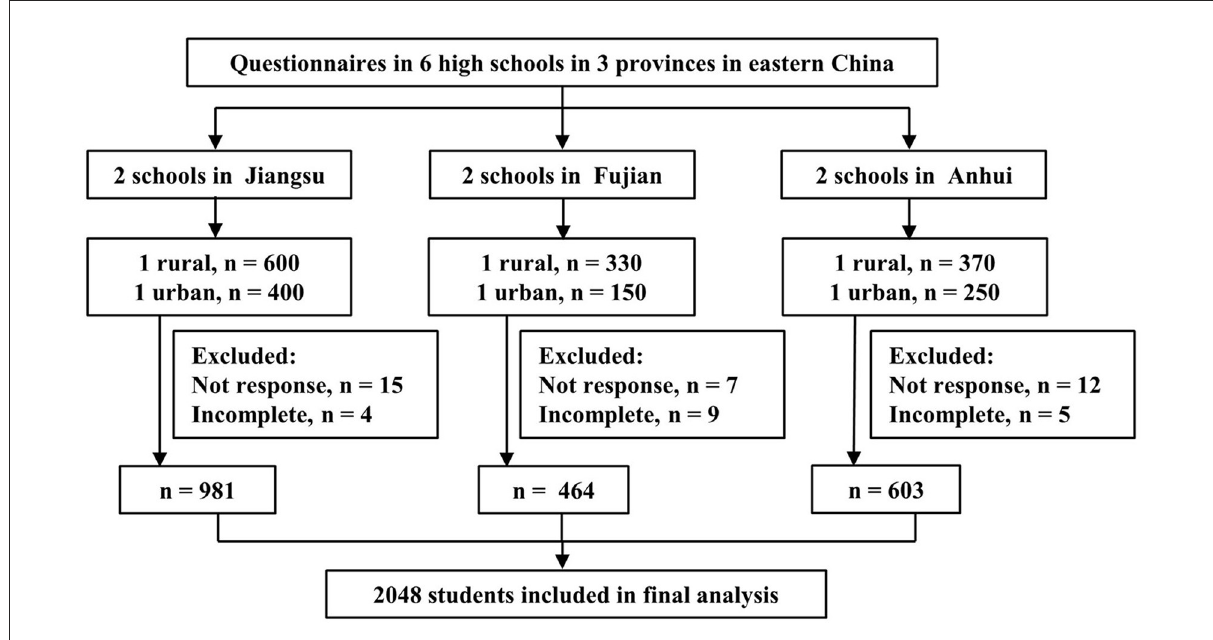
FIGURE1 Flow chart of selection of the study